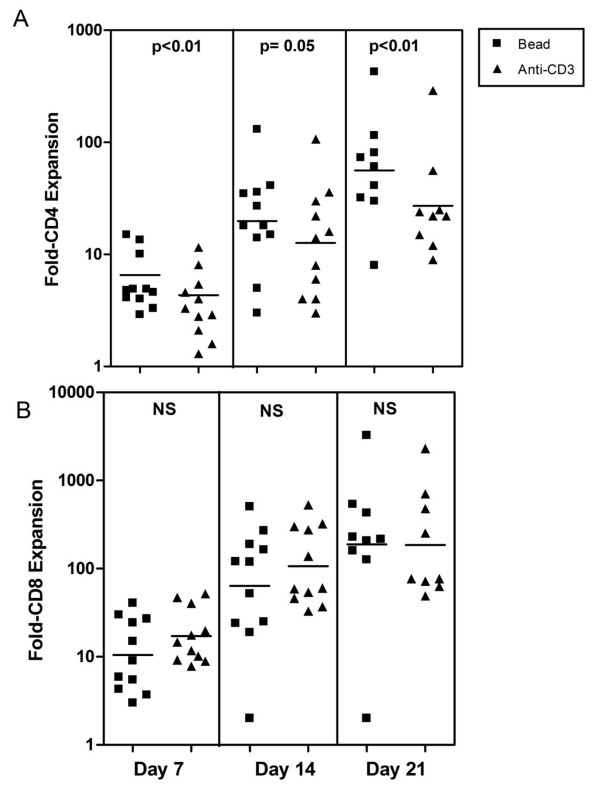
Comparison of CD4 (A) and CD8 (B) expansion after stimulation with anti-CD3/CD28 beads (squares) or anti-CD3 (triangles). Beads stimulated significantly greater CD4 expansion than anti-CD3 (p values for statistical significance at each time point is indicated at the top of each box). CD8 expansion was slightly greater in response to anti-CD3 at 7 and 14 days, but this trend was not statistically significant. The p values were calculated using the Wilcoxon matched pairs test.